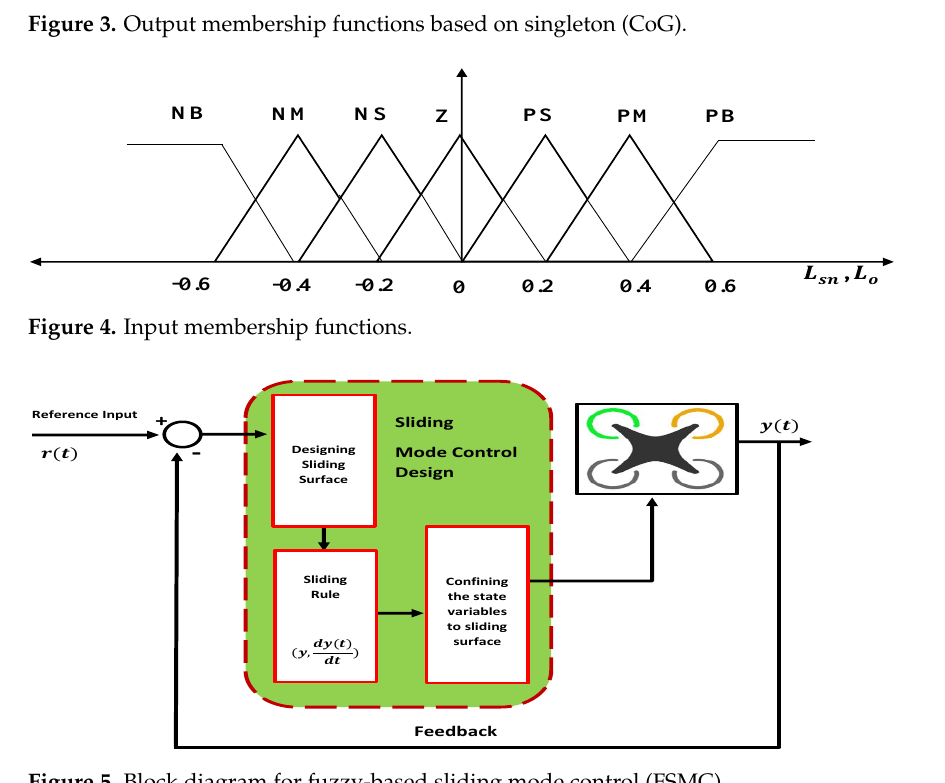
Figure 5. Block diagram for fuzzy-based sliding mode control (FSMC).